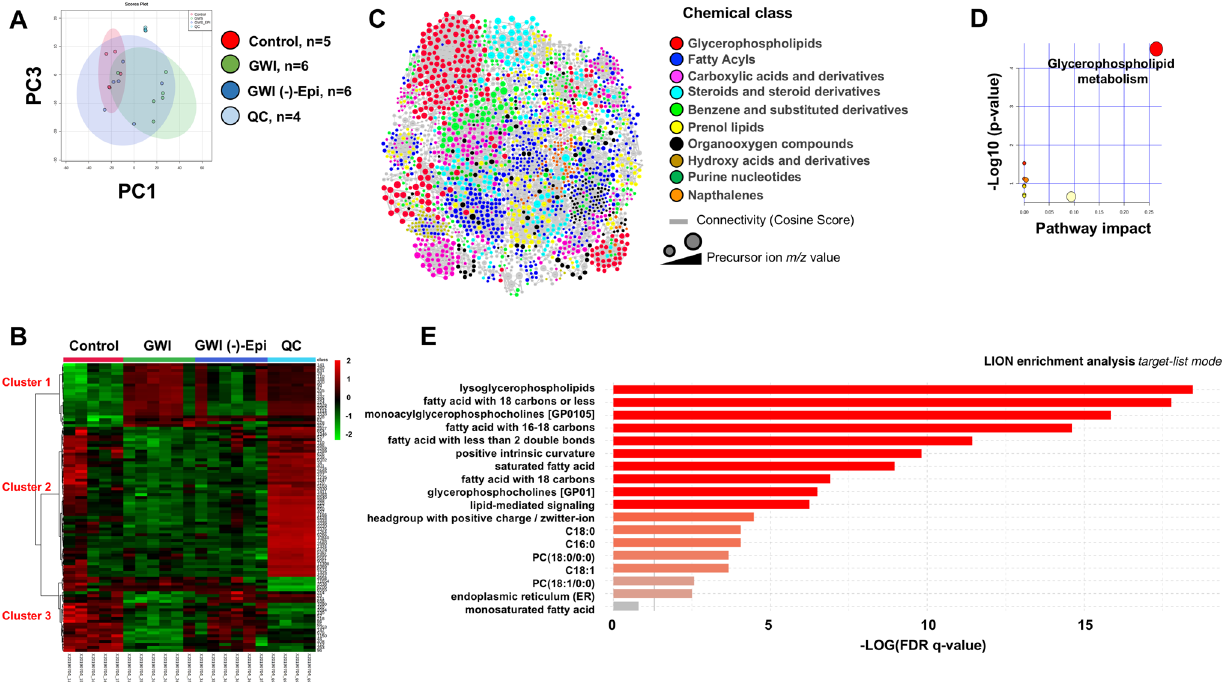
Figure 4. Untargeted metabolomics and chemoinformatic analyses of rat plasma. (A) Principal Component Analysis (PCA) on rat serum metabolomes. Data was log transformed without scaling. Shade areas depict the 95% confidence intervals. (B) Heat map of the top 100 metabolites ranked by ANOVA test. For hierarchical clustering analysis, Euclidean distance and ward linkage were used as methods. (C) Rat serum molecular network colored by the 10 most abundant metabolite chemical classes annotated by Classyfire. Each node represents a unique molecule and edges connecting nodes indicate structural similarity (according to a cosine score). (D) Pathway analysis of the up-modulated metabolites by toxicants in rat serum. Circles represent matched pathways. The color and size of the nodes are based on the adjusted p-value and pathway impact value, respectively. (E) Enrichment analysis of the up-modulated lipids by toxicants in rat serum using the “target-list mode” in LION/Web. The gray vertical line denotes the cut-off value of significant enrichments (q < 0.05). QC quality control